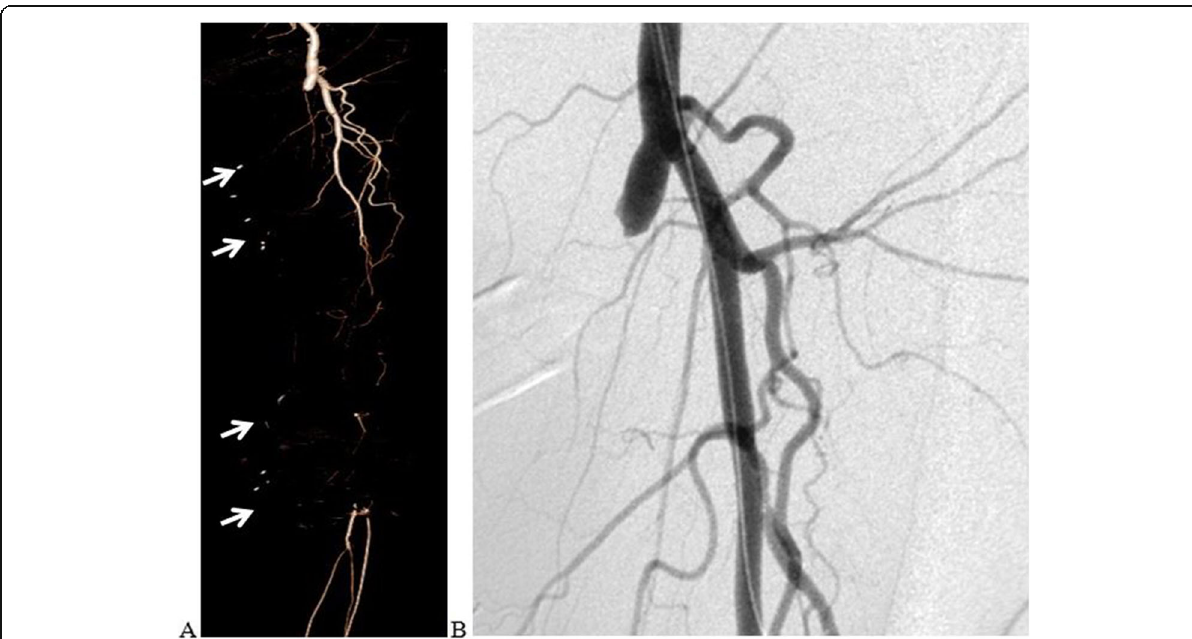
Fig. 2 Fluoroscopic images ( A ) demonstrating percutaneous transluminal angioplasty of all portions of the left superficial femoral artery. Subsequent angiography ( B ) shows PTA failure, defined by a flow-limiting dissection, after which multiple stenting is performed ( C ). Digital subtraction angiography ( D ) demonstrates successful recanalization of the left superficial femoral artery. A computed tomography angiography with 3D reconstruction ( E ), performed at 12 months follow-up, confirms patency of the native left superficial femoral